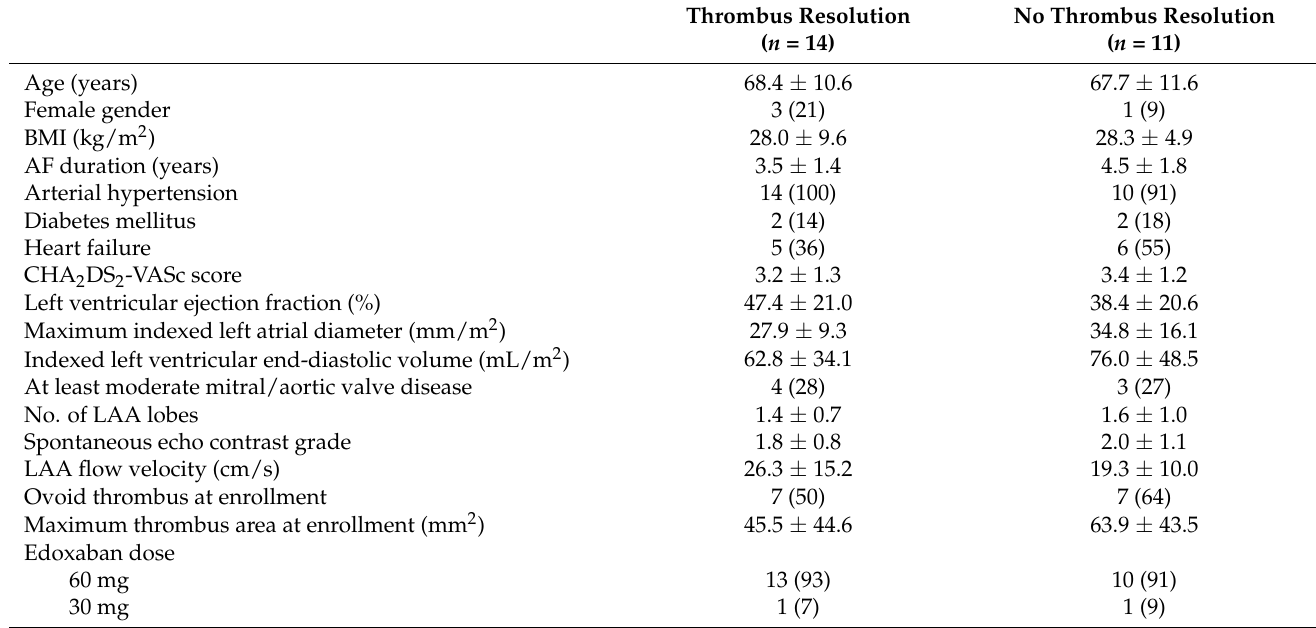
Table 3. Baseline characteristics in patients with and without thrombus resolution after 4 weeks of edoxaban